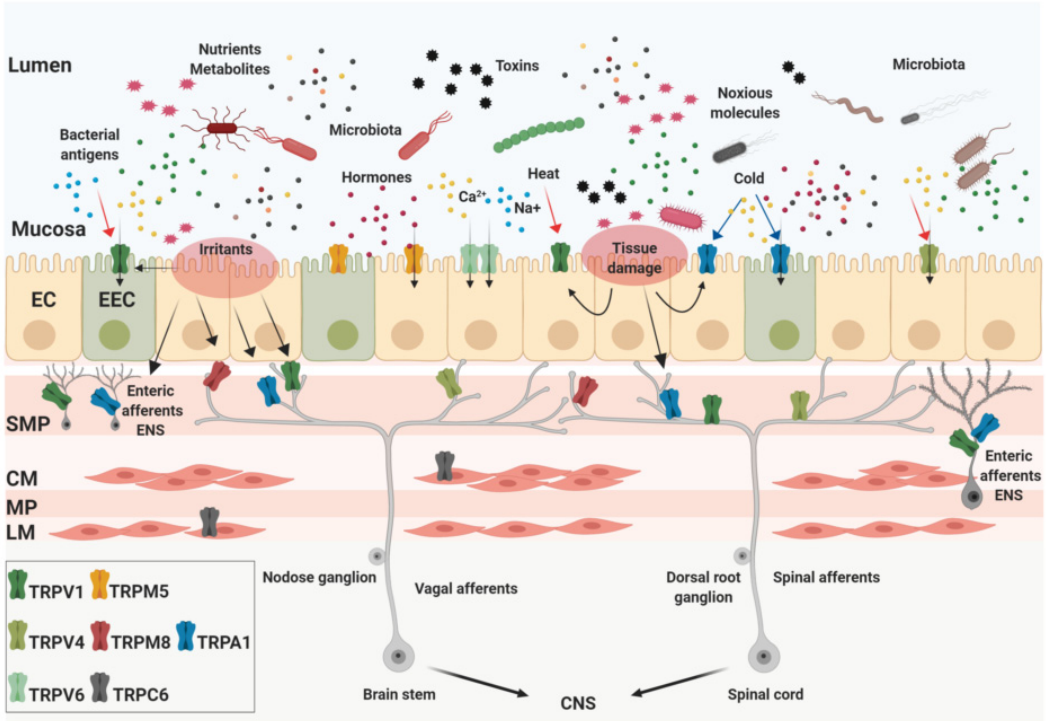
Figure 1. Expression of the transient receptor potential (TRP) channels in the gut. The intestinal lumen is densely populated by nutrients, gut microbial metabolites, chemicals, and toxins that can be present in the food ingested, released by the intestinal tissue or produced by bacteria. The gastrointestinal (GI) tract mucosa is mainly composed by epithelial cells (enterocytes, EC) and enteroendocrine cells (for instance enterochromaffin cells, EEC) whose apical membranes express several TRP channels. They act as sensors of specific stimuli such as temperature, pH, osmolality, mechanical stress, and recognize bioactive molecules. In addition to the mucosa, TRPs are located in almost all layers of the intestinal wall. Some of them are expressed by afferent neurons in the myenteric (MP) and submucosal plexus (SMP) as part of the intrinsic enteric nervous system (ENS). Two layers of muscle tissue, the circular (CM) and the longitudinal (LM) also express TRP channels. Finally, TRP channels expressed by extrinsic afferent nerves are implicated in the critical mechanism of visceral perception, transporting signals from the gut to the central nervous system (CNS). Created with BioRender.com. From a cellular point of view, TRP channels display, at least, three functional roles in the GI tract: